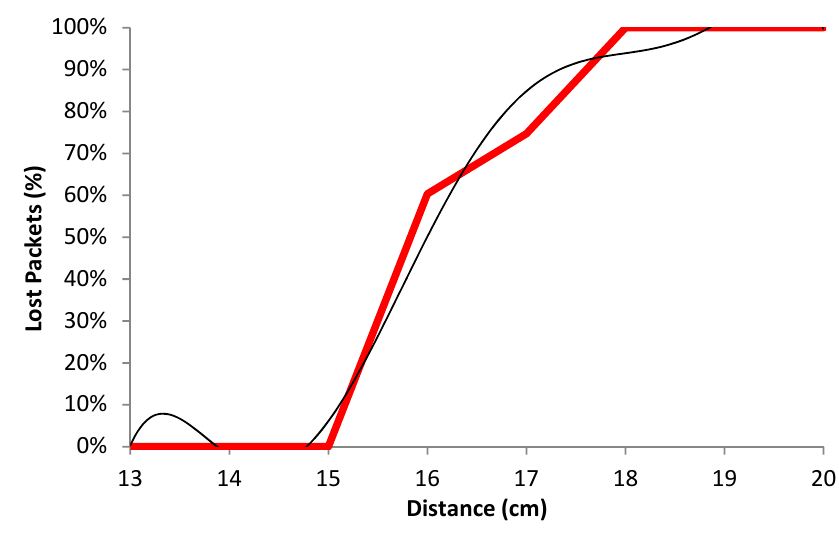
Figure 15. Average lost packets for 1